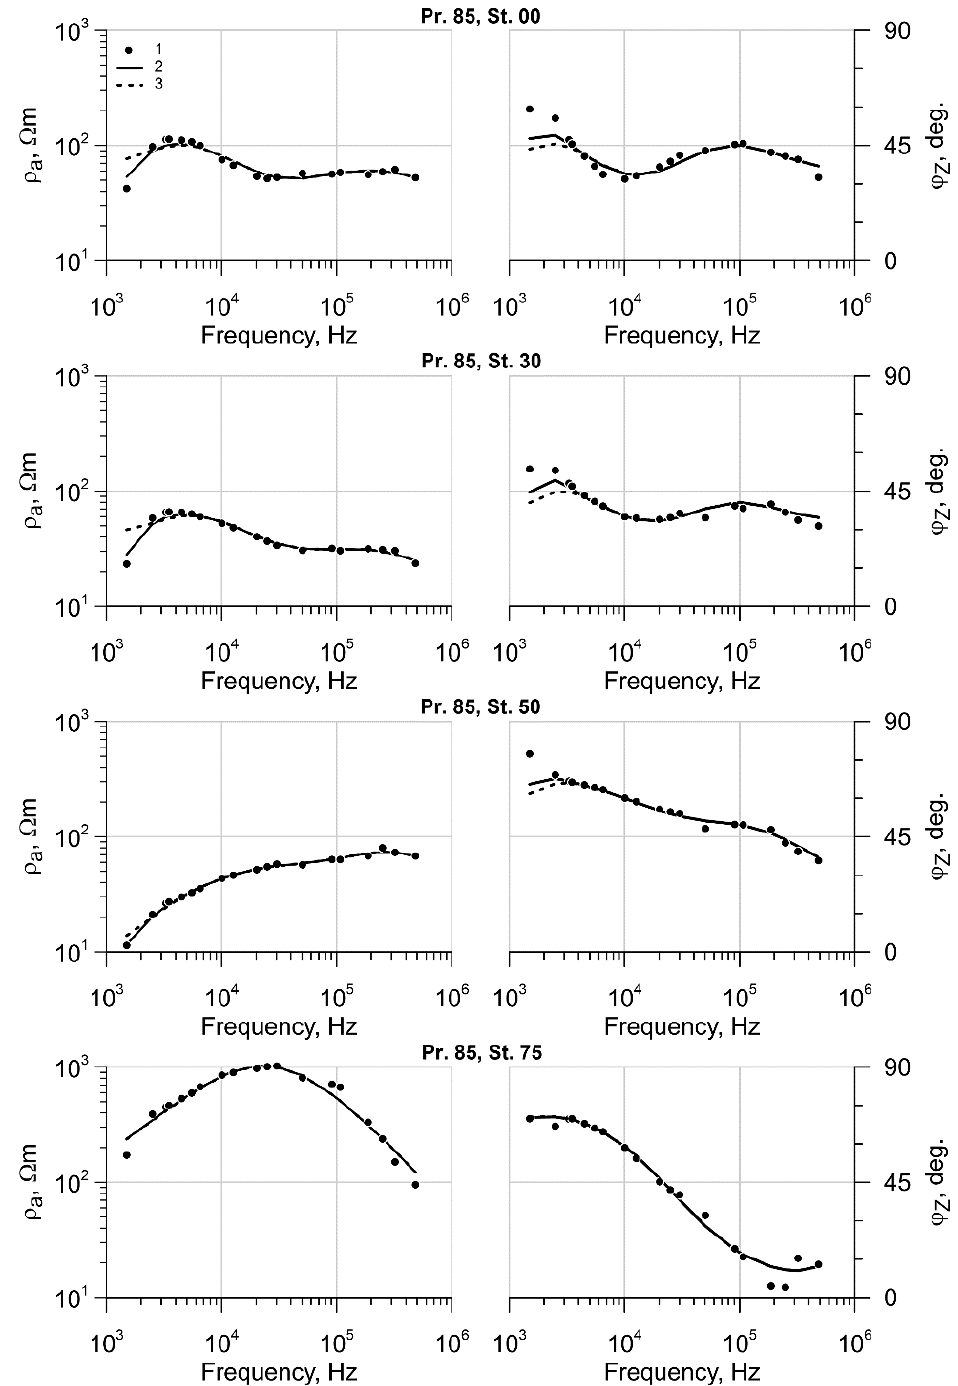
Figure 6. Examples of CSRMT apparent resistivity and phase curves. 1 — measured data, 2 — synthetic data after 1D controlled source inversion considering the transition zone, 3 — synthetic plane wave responses for the model after controlled source inversion. The positions of selected stations are marked in Figure 5.